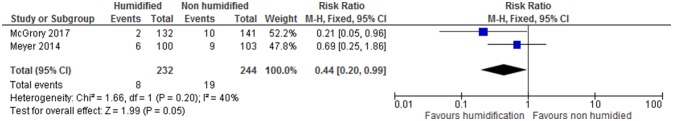
Severe intraventricular hemorrhage (Grade 3 or 4).